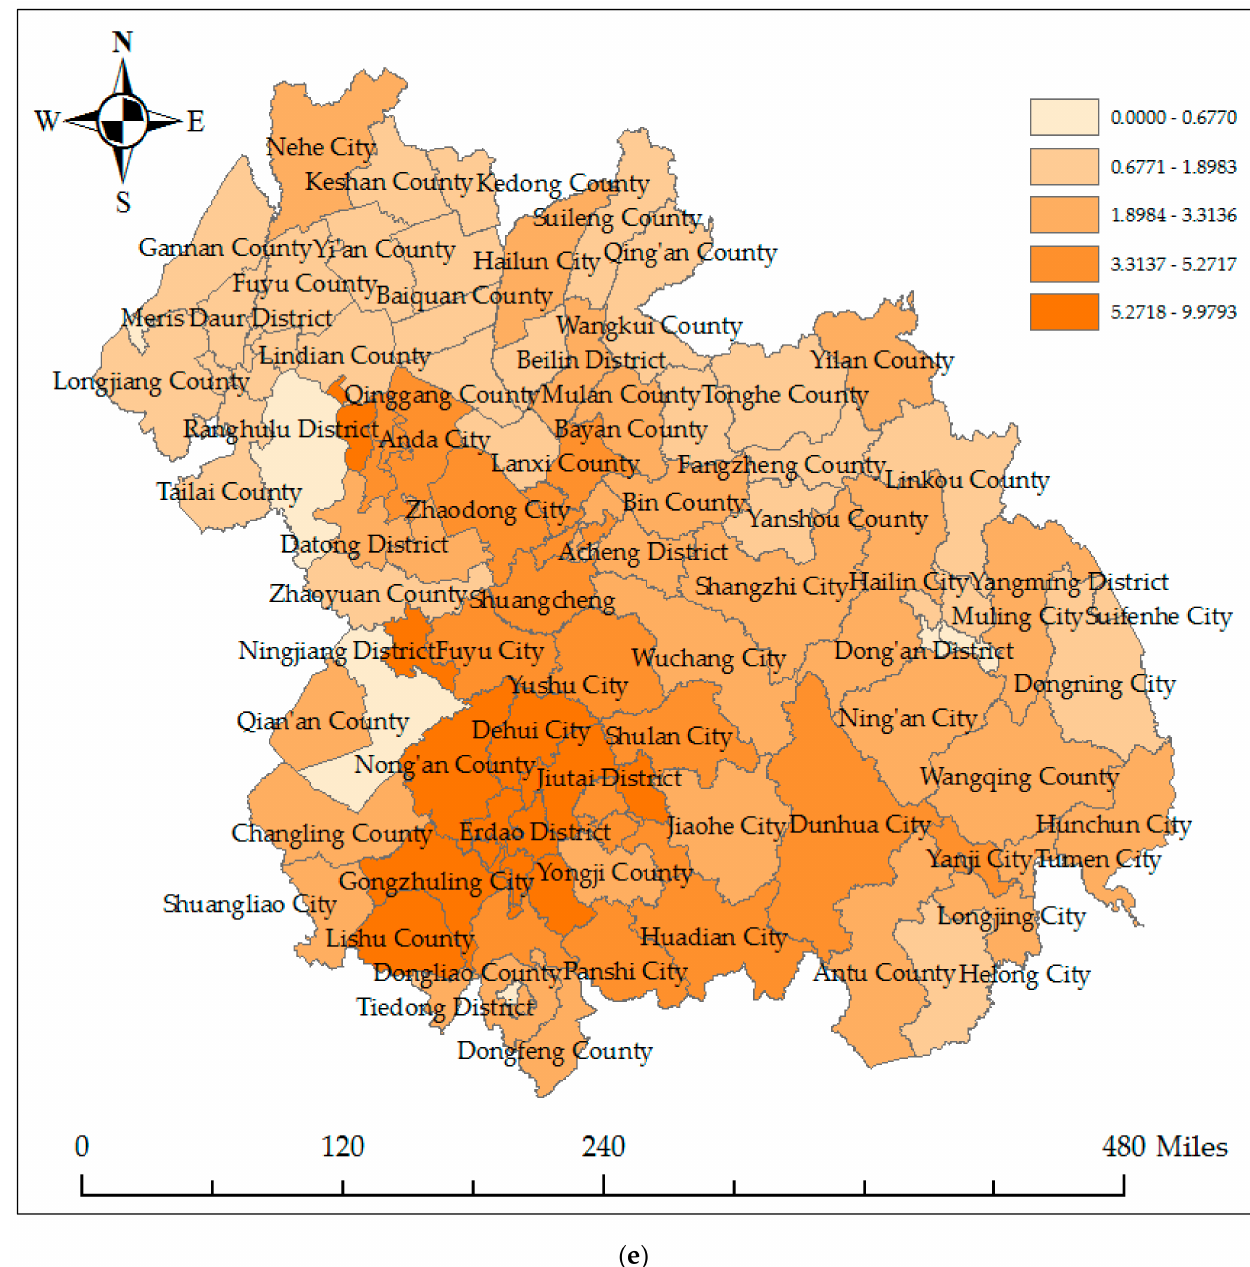
Figure A1. The spatial distribution of the carbon emissions in Harbin–Changchun urban agglomeration: ( a ) 1997; ( b ) 2002; ( c ) 2007; ( d ) 2012; ( e )